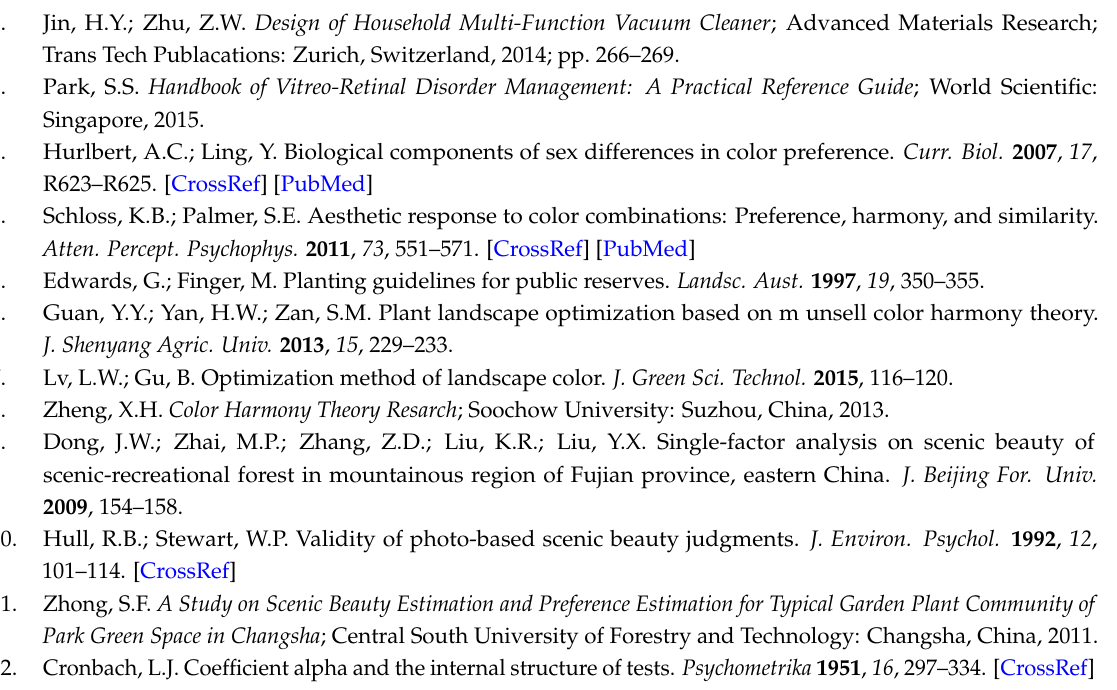
Figure S1: Original HSV color model and normalization process for Black and White: (a) HSV color model; (b) Modified HSV color model, Figure S2: Hue, Saturation and Value un-uniform quantization: (a) Hue panel; (b) Saturation partition; (c) Value partition, Figure S3: SV color table of H1 and H7 with familiar color partitions, Figure S4: MATLAB application process flow, Figure S5: Dynamic change in forest hue over three months, Table S1: Differences in forest hue over three months, Table S2: Differences in forest saturation and value over three months, Table S3: Differences in forest color numbers over three months, Table S4: Values of six simplified factors and significant correlation factors regarding the images, Table S5: Differences in forest color variables in six